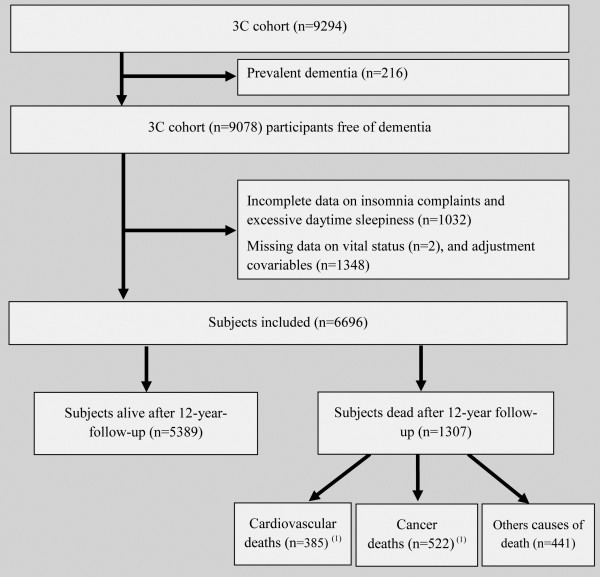
Flow diagram.(1) For 41 participants, the cause of death was related to both cardiovascular and cancerb.